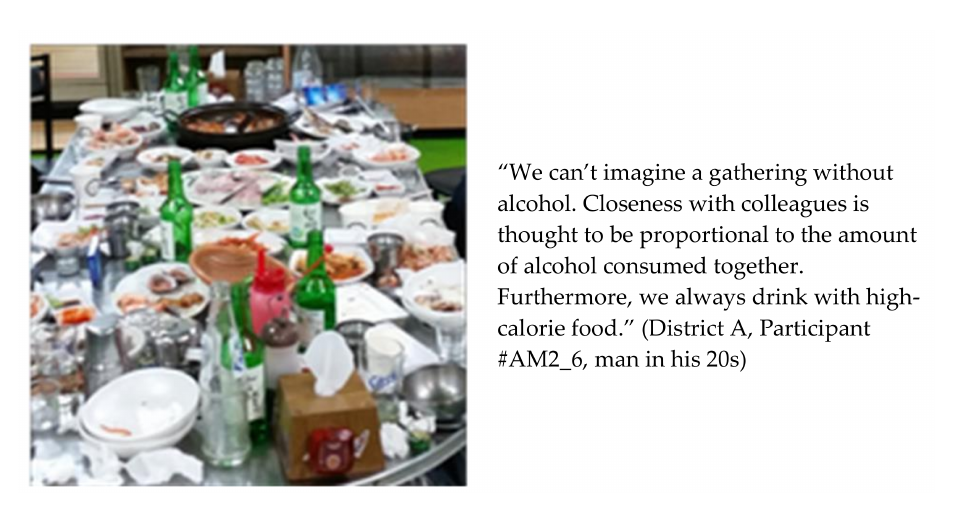
Figure 6. Picture and statement depicting a table with food and